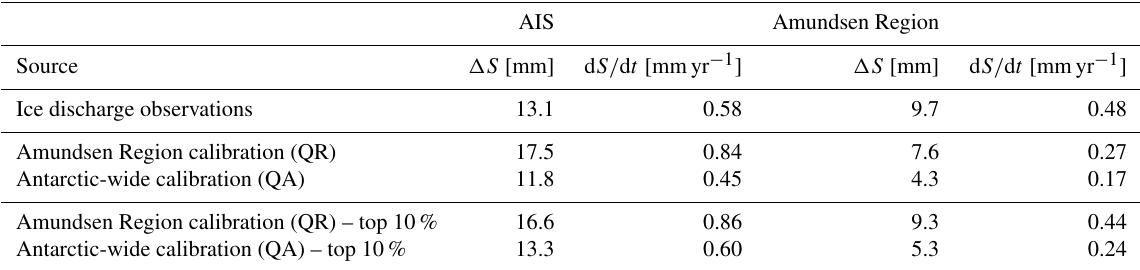
Table 7. The median cumulative sea level contribution ( (cid:49)S ) over the hindcast period 1979–2017 and the rate (d S/ d t ) over the last decade (2008-2017) of the hindcast period for the two calibration methods (Amundsen Region and Antarctic-wide) and for the ice discharge ob- servations of Rignot et al. (2019). Results are shown for the quadratic basal melt parameterisation with thermal forcing near the ice shelf